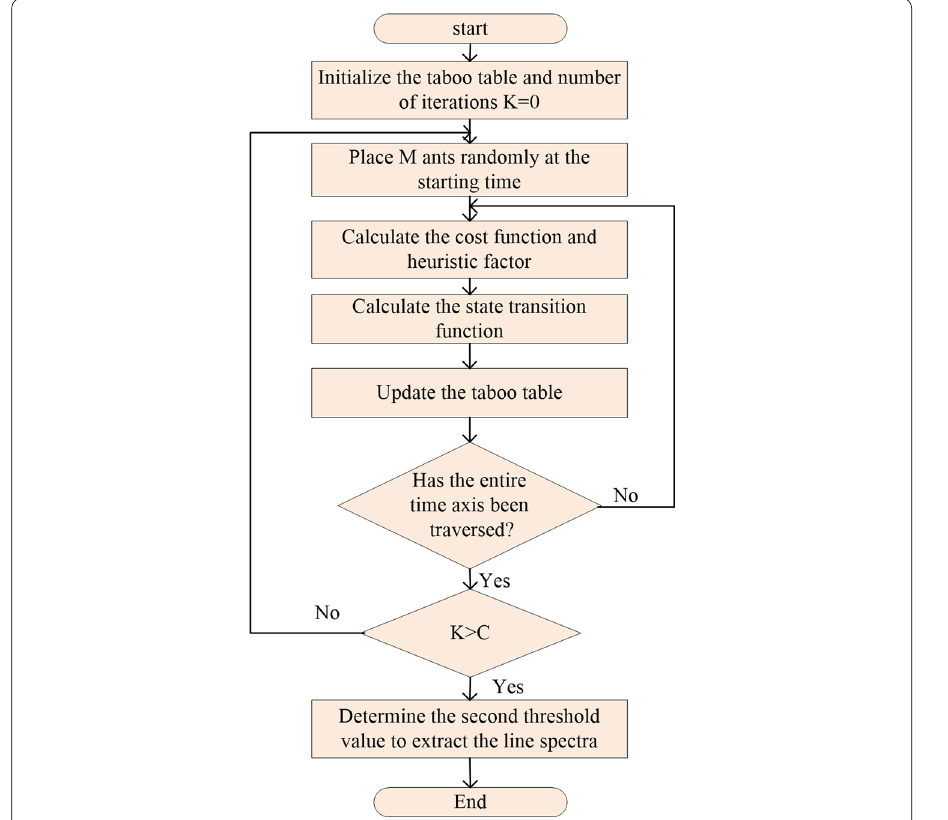
Fig. 4 Flowchart of algorithm